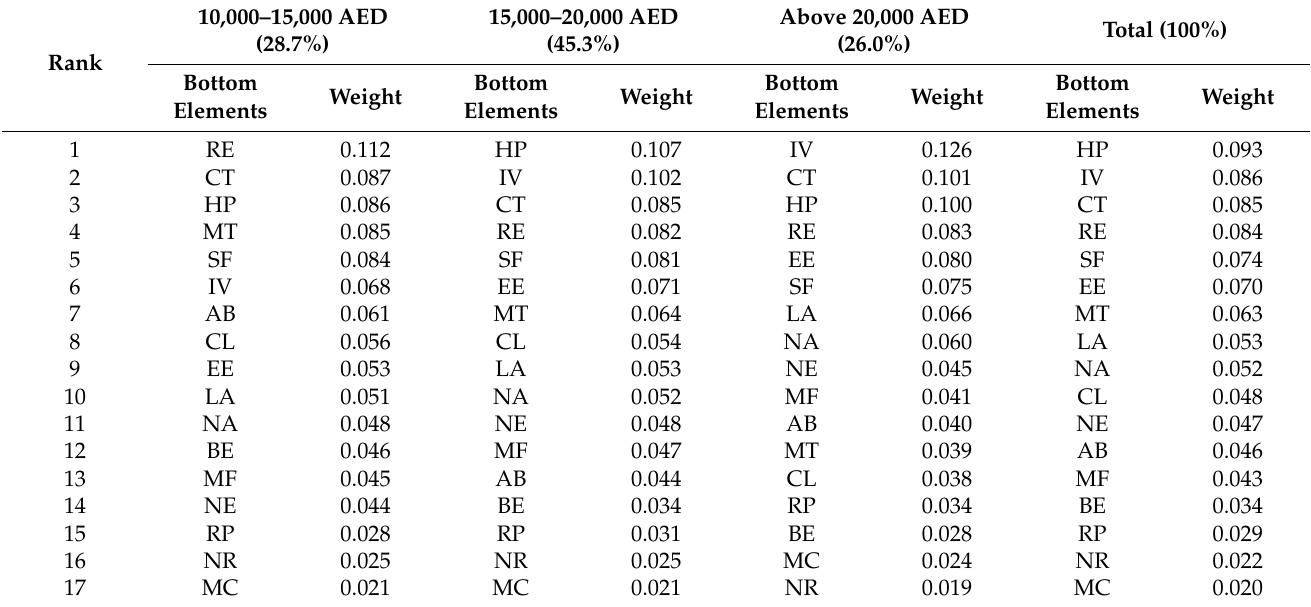
Table 9. The AHP Analysis of Monthly Income